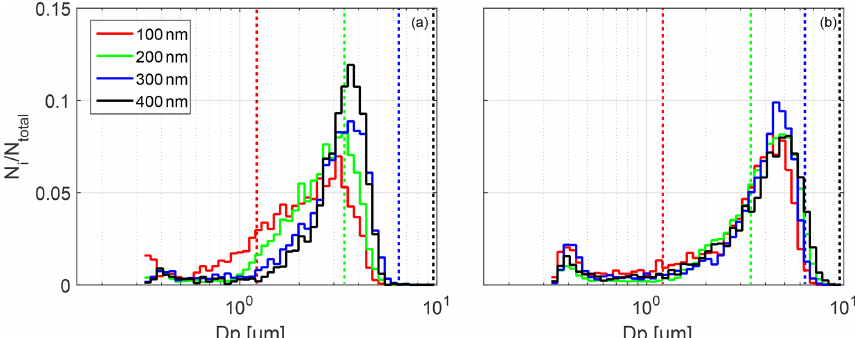
Figure 11. Droplet formation and growth of differently size-selected, monodisperse NaCl particles ( D p , dry = 100 − 400nm) for (cid:49)T = 16K measured at two different positions below the aerosol inlet ( a : z 4 = 40cm, b : z 8 = 80cm). The dotted lines represent the critical diameters D p , crit for particle activation which are 1.2, 3.4, 6.3 and 9.7µm for D p , dry = 100, 200, 300 and 400nm,